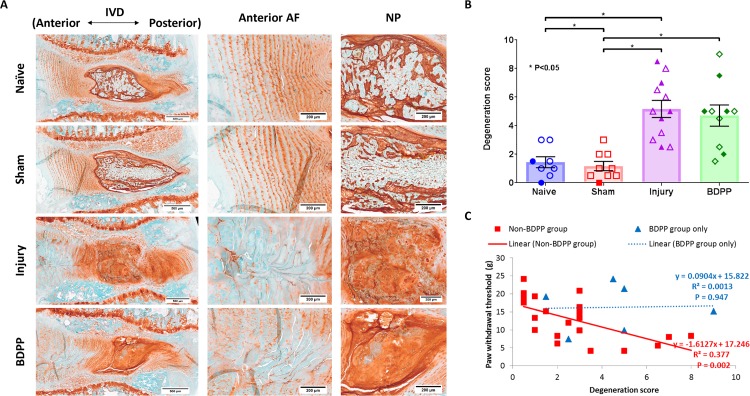
BDPP treatment did not prevent morphological IVD degeneration induced by injury.(A) Representative histological section of IVDs from Naive, Sham, Injury and BDPP groups obtained at 6-week post-op. Scale bar: 500μm. (B) Morphological changes of the designated experimental IVDs represents using a degeneration scale between 0 and 10 (0 = normal and 10 = severe degeneration). Since the degeneration scores of the IVDs from 1-week and 6-week study did not show a significant difference, they were pooled together for statistical analysis. Scatter plots present the degeneration score from individual animals across the experimental groups (n = 8 for Naïve, n = 9 for Sham, n = 12 for Injury & n = 10 for BDPP). Open and solid symbols represent data obtained at weeks 1 and 6 post-op, respectively. Cross bars present group mean±SEM values. * indicates P<0.05 between groups. (C) Pearson’s correlation analysis between paw withdrawal threshold and degeneration score for Non-BDPP groups (i.e. Naïve, Sham and Injury groups) and BDPP group only. Scatter plots present data points of individual animal; solid-trendline presents significant correlation; dotted-trendline presents non-significant correlation.